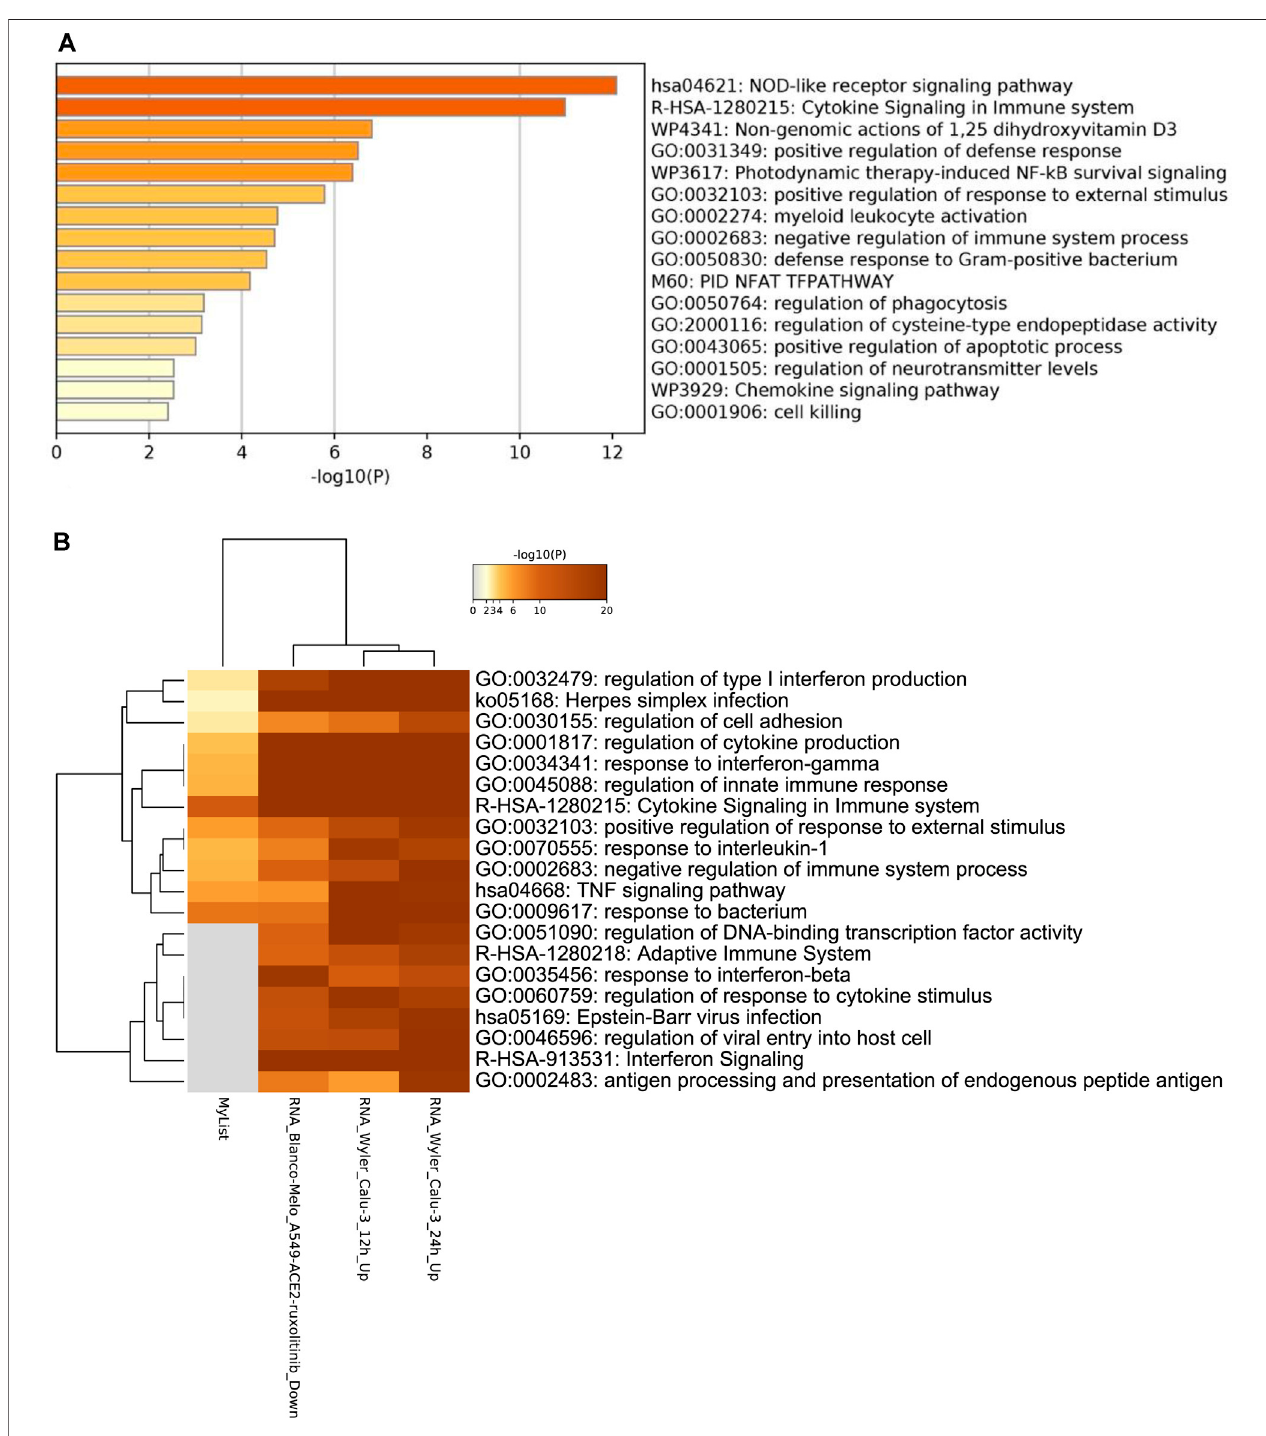
FIGURE 9 | (A) Gene term enrichment for the differential expression genes in RVA-16 and RVC-15 (B) Gene term enrichment for COVID-19 pathways.